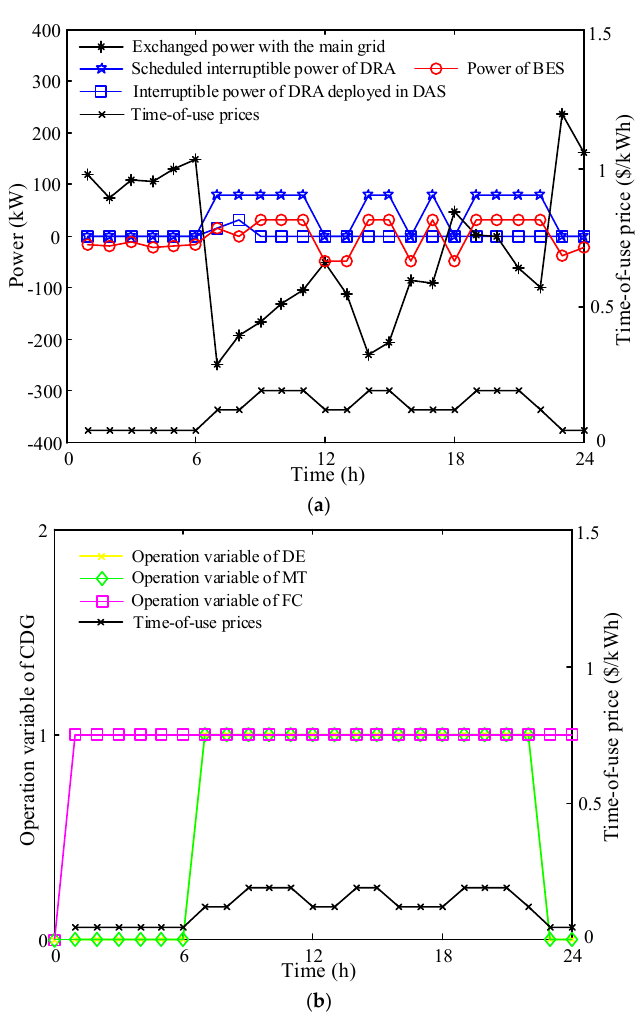
Figure 7. Decision variables of the DAS that are passed to the HAS: ( a ) Exchanged power with main grid as well as the power of BES and DRA; ( b ) Operation variable of